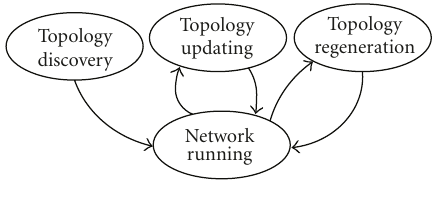
Figure 2: Phases of topology control.